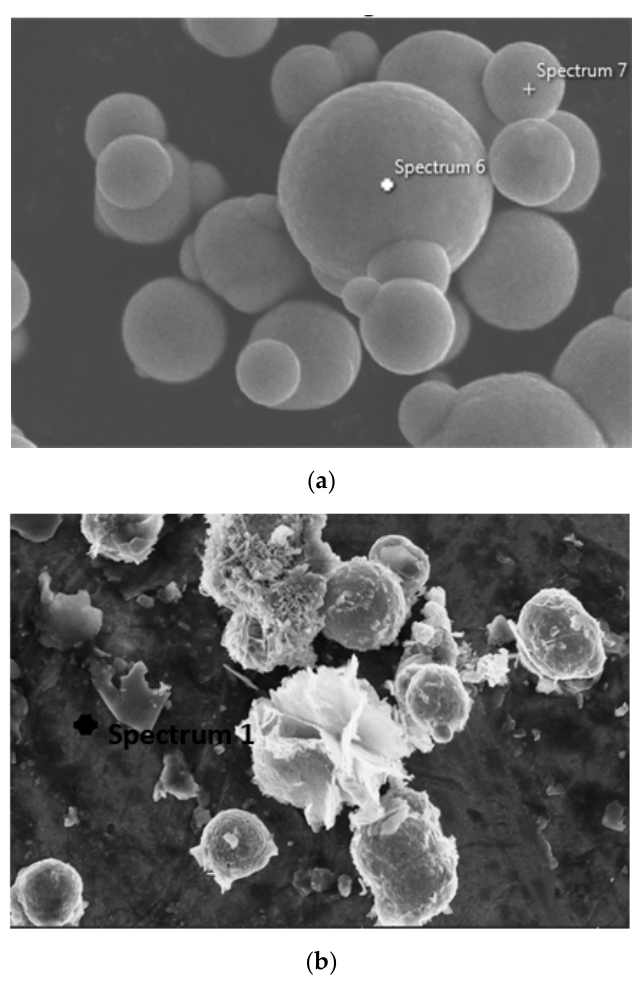
Figure 2. EDX point analysis at 10,000× magnification for ( a ) non-corroded and ( b ) corroded CIPs.